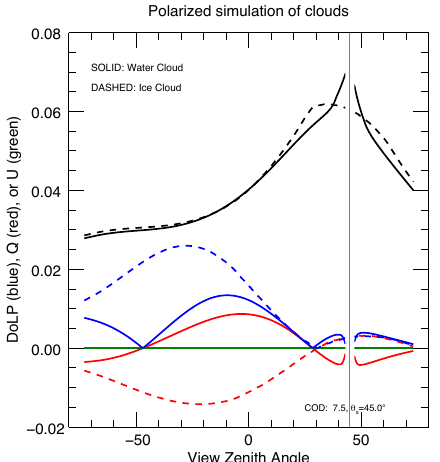
Figure 2. Simulated ground observation of a liquid and ice phase cloud in the solar principal plane. The simulation wavelength was 870nm, COD was 7.5, and solar zenith angle 45 ◦ . The water cloud (solid lines) had droplets with an effective radius of 10µm, while the ice cloud (dashed lines) was comprised of crystals with an as- pect ratio of 20 and roughness parameter of 0.4. Both simulations used an isotropic surface reflectance of 0.391, which was observed at 870nm for a vegetated surface by Knobelspiesse et al. (2008). DoLP (blue), Q (red), and U (green) are expressed with the axis on the left, while I (black) with the axis on the right. Values within 2 ◦ of the incoming solar direction (45 ◦ , indicated by the thin vertical line) were omitted for graphical clarity.